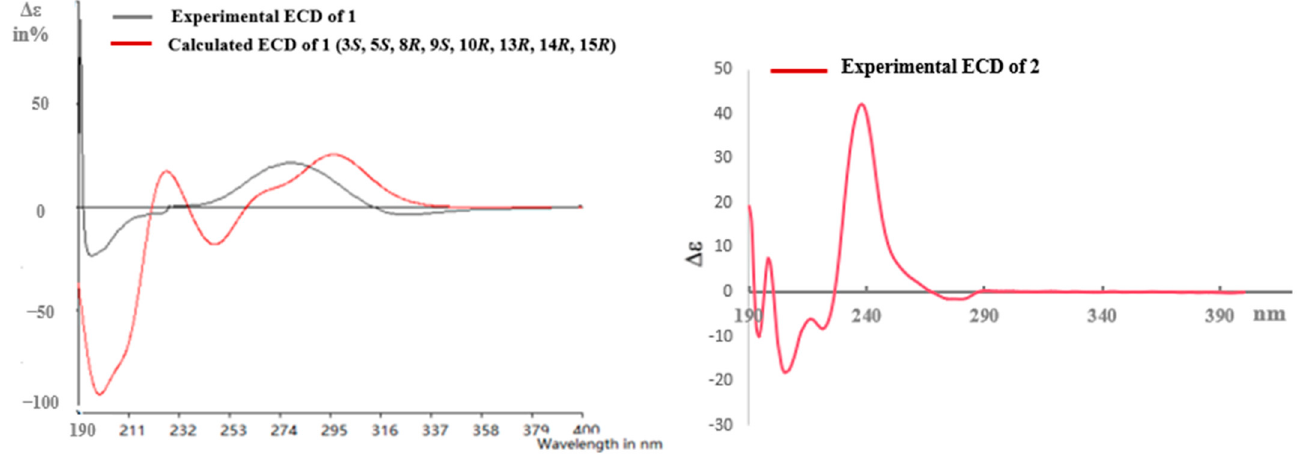
Figure 2. Calculated and experimental ECD for 1 and experimental ECD for 2.